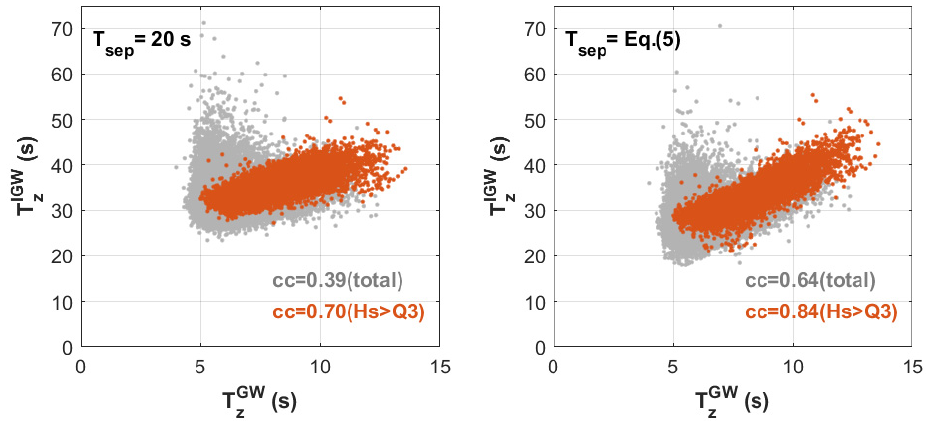
Figure 8. Scatter diagrams between T IGW z and T GW z according to use of the two di ff erent separation periods.